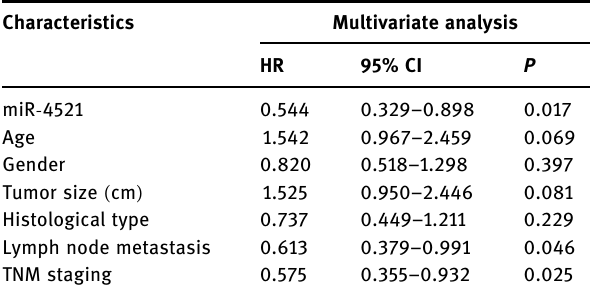
Table 2: Multivariate Cox analysis of clinical parameters in relation to overall